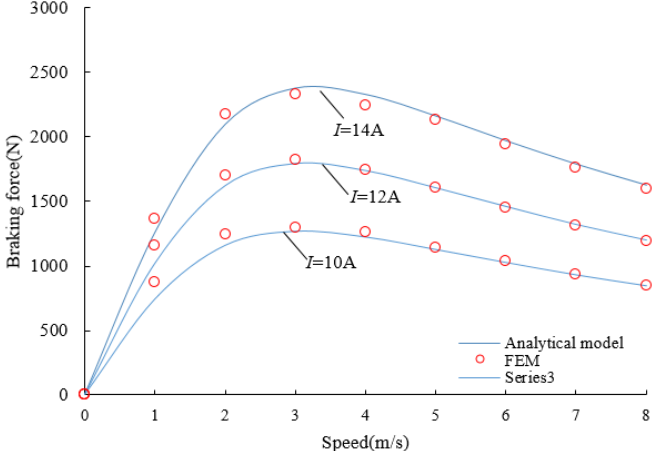
Figure 11. Braking force-speed characteristic for different excitation currents.